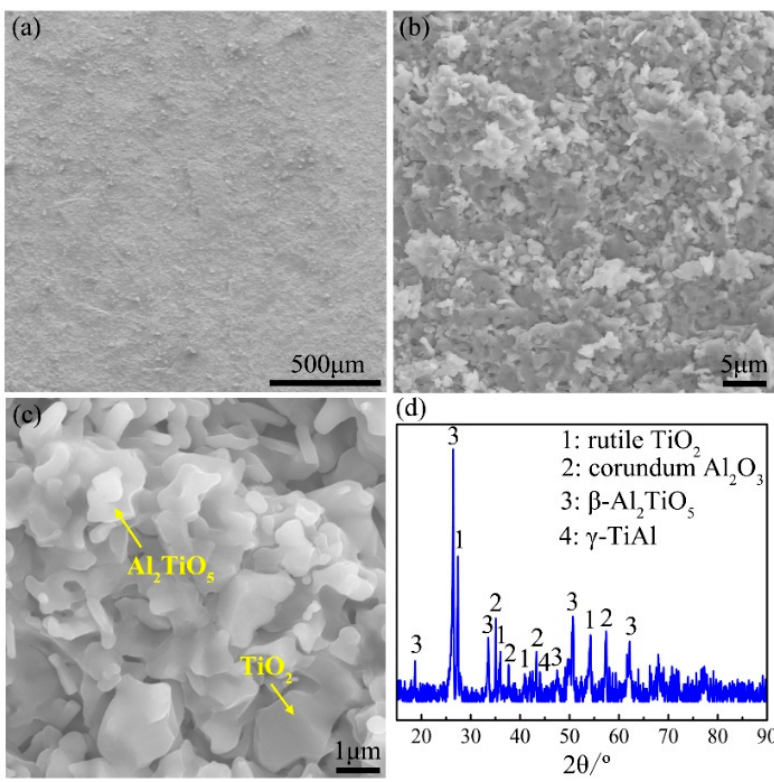
Figure 13. ( a – c ) Surface morphologies and ( d ) XRD pattern of the oxide scale formed during heating the Ti-46Al-2Cr-5Nb alloy to the end of Stage V.